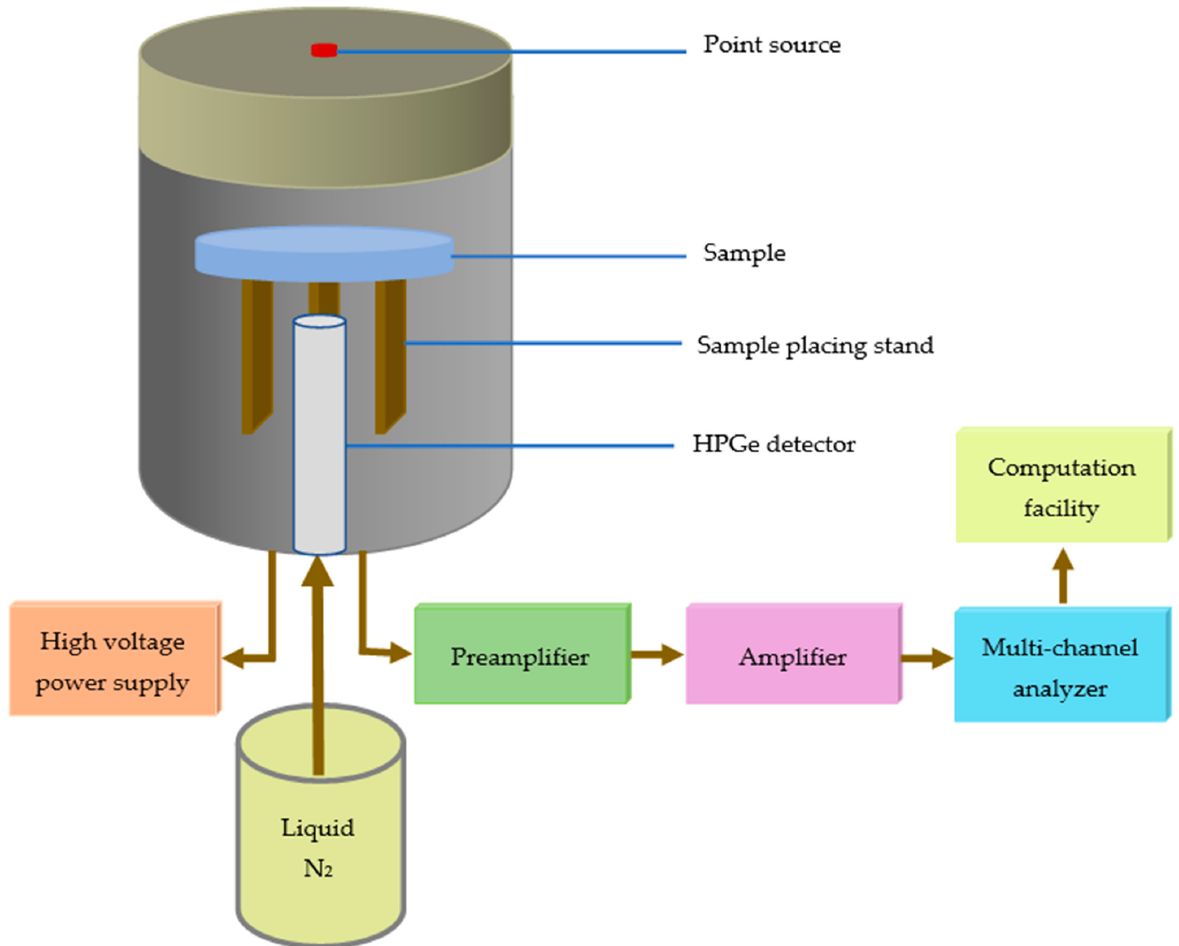
Figure 1. Illustration of setup of the experimental work. Figure 2. Illustration of setup of the experimental The experimental linear attenuation coefficient (LAC) was determined using the fol- lowing equation [30,31]: